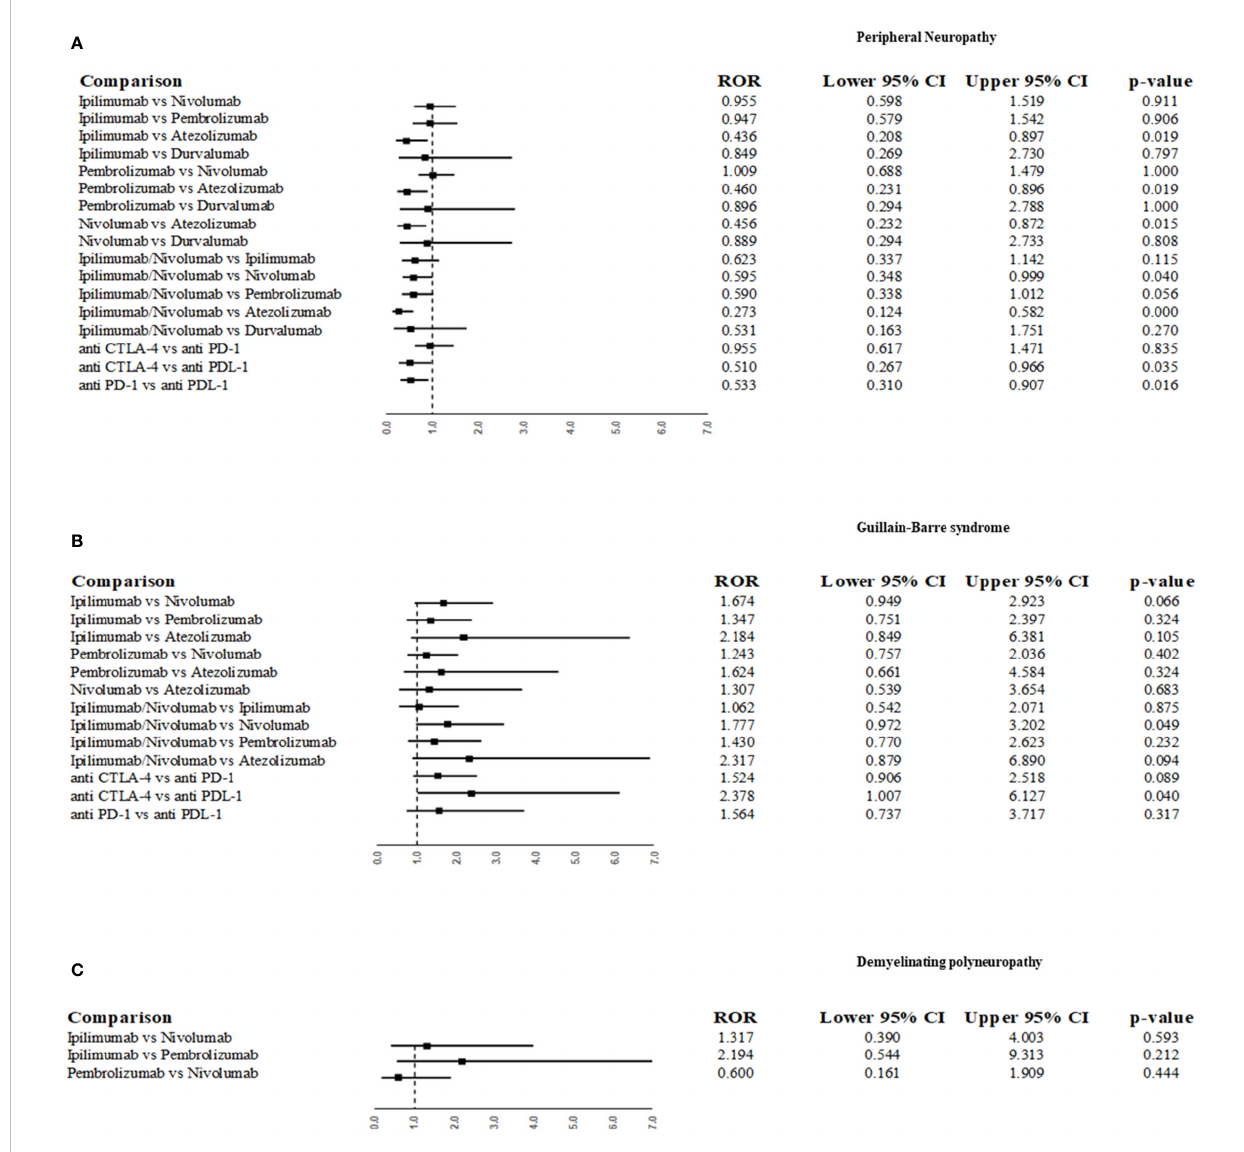
FIGURE 3 Reporting odds ratio (ROR) for disproportionality analysis of the most frequently reported peripheral neuropathies as suspected ADRs associated with ICIs. ROR was performed for the following p-term “ neuropathy peripheral ” (A) , “ Guillain-Barre syndrome ” (B) and “ demyelinating polyneuropathy ” (C)